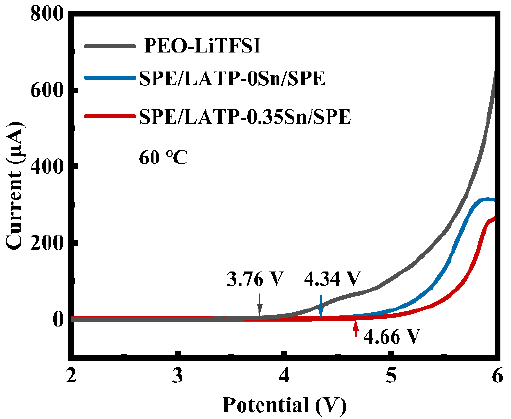
Figure 6. LSV curves of PEO-LiTFSI, SPE/LATP-0Sn/SPE, and SPE/LATP-0.35Sn/SPE solid electro- lytes.